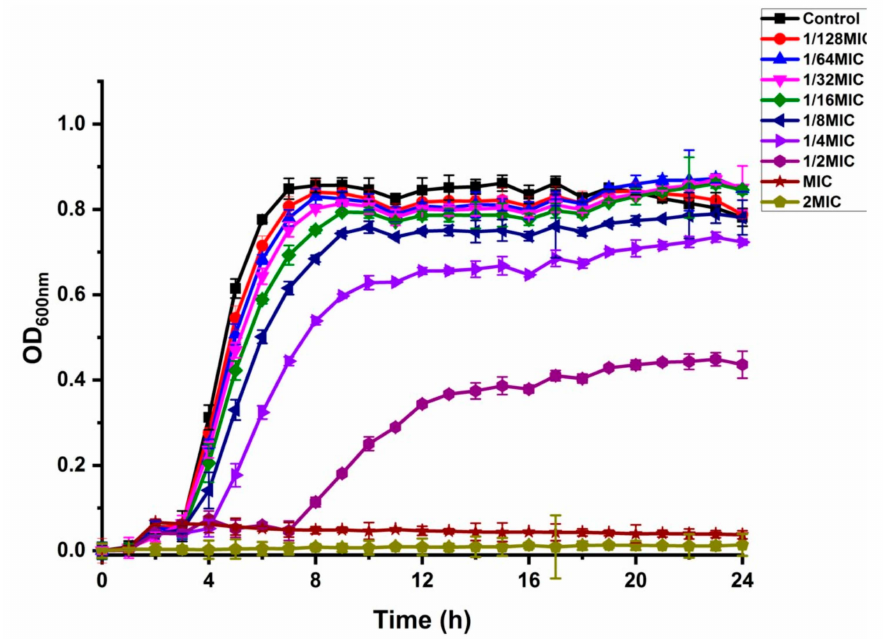
Figure 1. The effect of shikonin on the growth curve of strain ATCC29213. Each value was represented by the average of three independent experiments, and the line represents the standard